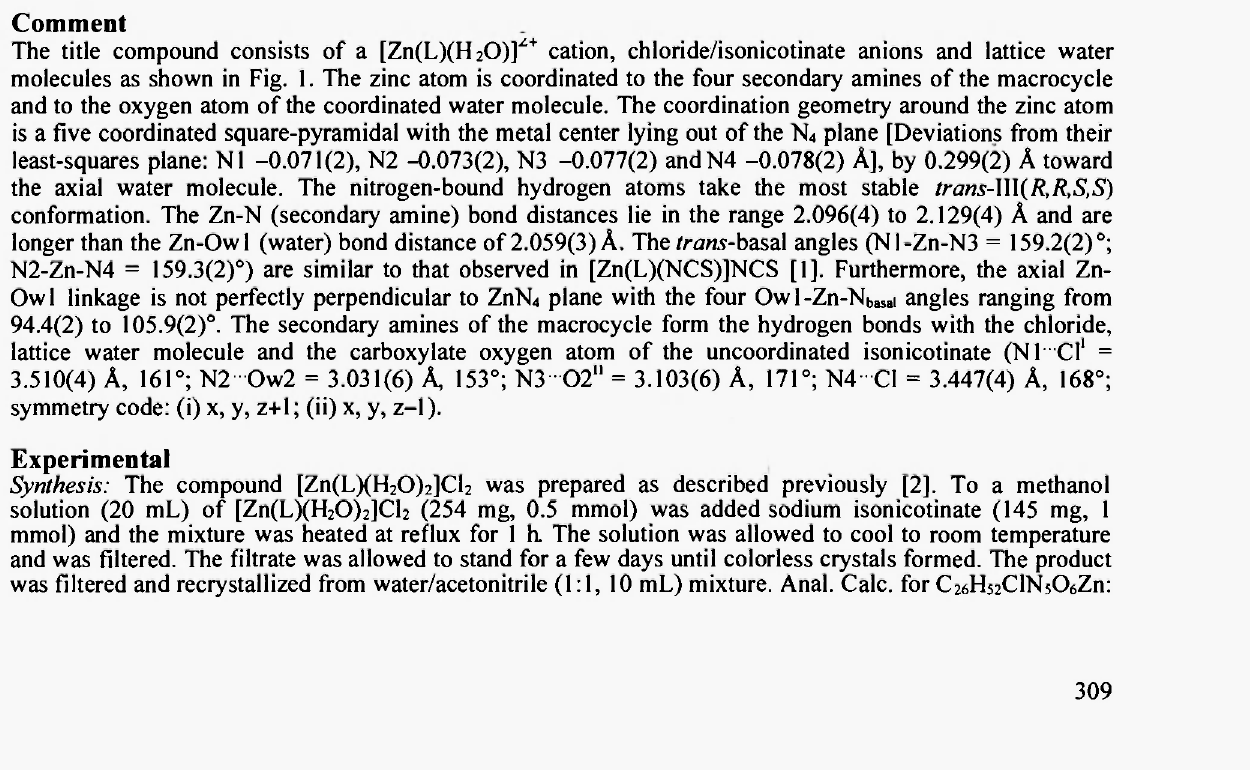
Figure 1. An ORTEP plot showing the molecular structure "of [Zn(L)(H20)]ClINT-3H 2 0 (30% probability ellipsoids). Selected bond distances and angles: Zn-Nl 2.106(4), Zn-N2 2.120(4), Zn-N3 2.096(4), Zn-N4 2.129(4), Zn-Owl 2.059(3), Ol-C21 1.243(7), 02-C21 1.253(7), N5-C24 1.329(9), N5-C25 1.326(9) Ä;N1- Zn-N2 90.2(2), Nl-Zn-N3 159.2(2), Nl-Zn-N4 82.5(2), N2-Zn-N3 82.7(2), N2-Zn-N4 159.3(2), N3-Zn-N4 97.4(2), Owl-Zn-Nl 98.7(2), Owl-Zn-N2 105.9(2), Owl-Zn-N3 102.0(2), Owl-Zn-N4 94.4(2), 01-C21-02 125.6(6), Ol-C21-C22 117.3(5), 02-C21-C22 117.1(5), C24-N5-C25